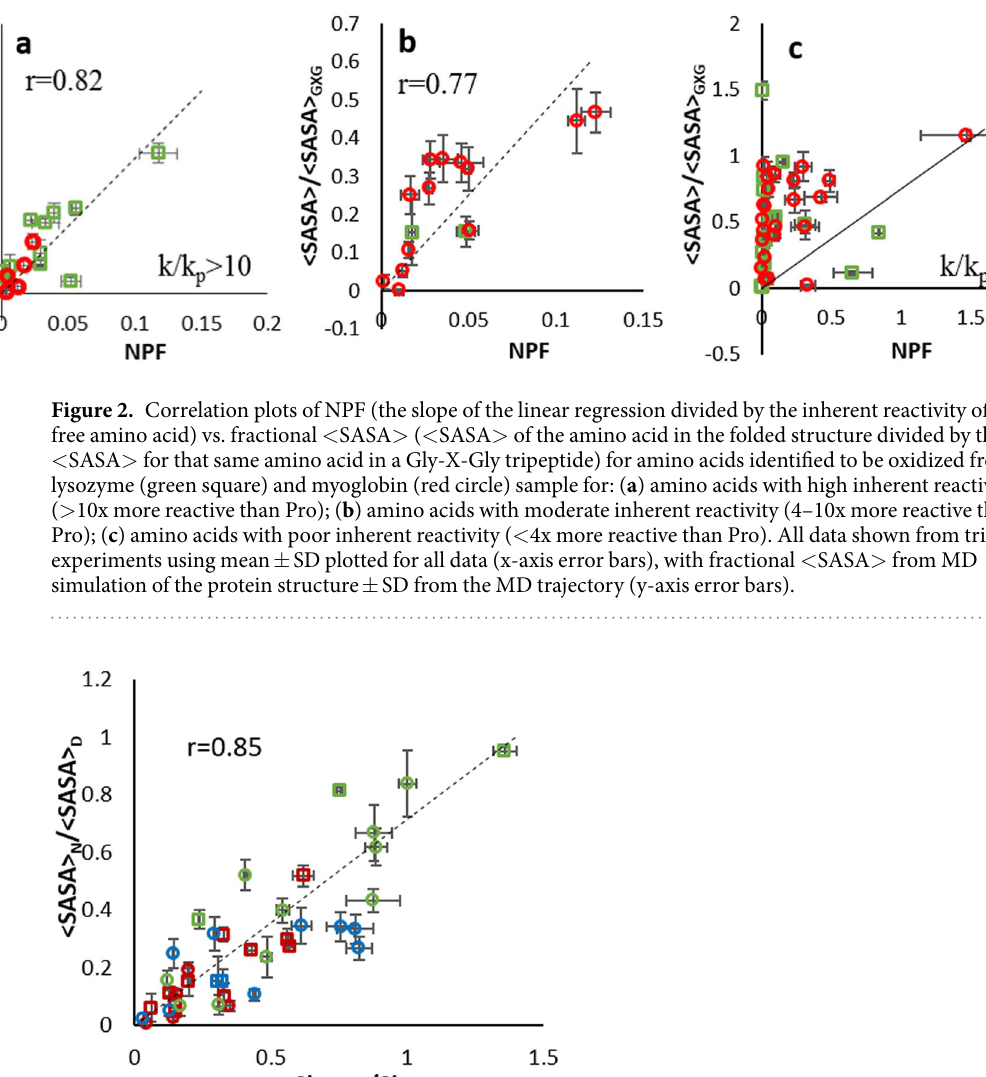
denatured protein, minimizing the contact of the side chains from neighboring residues while maintaining the sequence context. The denatured protein data showed appearance of oxidation on residues with high intrinsic reactivity to hydroxyl radicals but low < SASA > in the native form, as well as disappearance of oxidation on poorly reactive residues that were oxidized in the native form due to increased competition from other residues. A total of 24 amino acids from myoglobin and 16 from lysozyme were found to be oxidized in both the native and denatured conformations (Supplementary Table 2). Plotting the ratio of the reactivity (native: denatured) versus the ratio of < SASA > (native: denatured) greatly improves the correlation between measured radical response rates from multi-point HR-HRPF data and fractional < SASA > (Fig. 3): r = 0.85 for all amino acids measured, with no noticeable change in correlation between highly reactive (Fig. 3, red) and poorly reactive (Fig. 3, green) amino acids. Correlating the fractional < SASA > of the same set of amino acids using multi-point HR-HRPF data from the native fold and normalizing by free amino acid reactivity results in a much worse correlation with a wide deviation of poorly reactive residues (Supplementary Fig. S1). These results clearly indicate that the sequence context of a folded protein can significantly effect on the inherent reactivity of each amino acid, and this effect accounts for the bulk of the error found in correlations attempting to normalize based on free amino acid